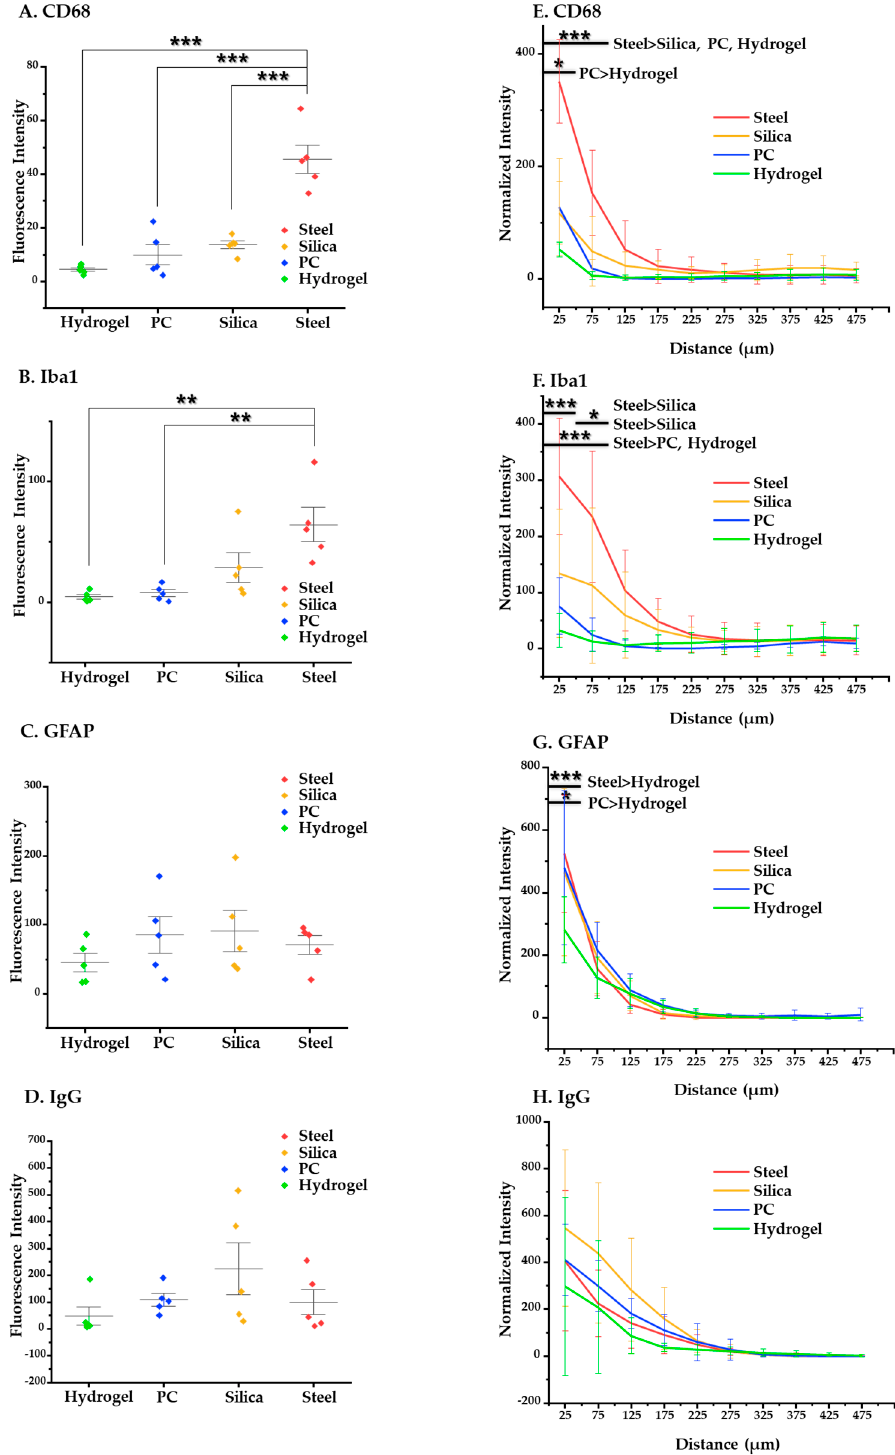
Figure 10. Statistical results of the chronic (4 weeks) immune response. ( A – D ) Results of the post- hoc Tukey’s test on one-way ANOVA with the mean values of intensity of each immune marker: ( A ) CD68; ( B ) Iba1; ( C ) GFAP; ( D ) IgG. ( E – H ) Results of post-hoc Tukey’s test on the two-way ANOVA based on distance, showing intensity profiles of each immune marker: ( E ) CD68, ( F ) Iba1, ( G ) GFAP, and ( H ) IgG. The error bars represent the standard deviation. Significance: *: p < 0.05, **: p < 0.01, and ***: p < 0.001.